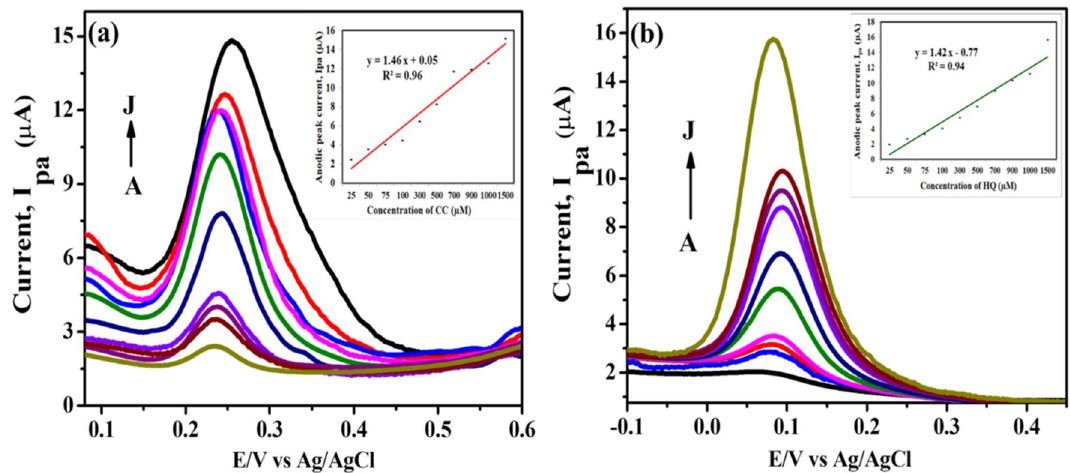
Figure 10. ( a ) DPV illustrating the effect of individual concentrations of ( a ) CC (A to J: 25, 50, 75, 100, 300, 500, 700, 900, 1000 and 1500 µM) in 0.1 M PBS at CNCs/Zn-TPP/GCE electrode and ( b ) HQ (A to J: 25, 50, 75, 100, 300, 500, 700, 900, 1000 and 1500 µM). Insets: Calibration curve between different concentrations of analytes vs. anodic peak